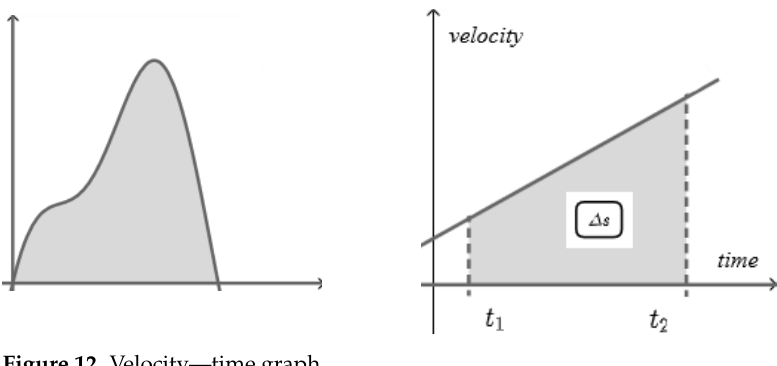
Figure 12. Velocity—time